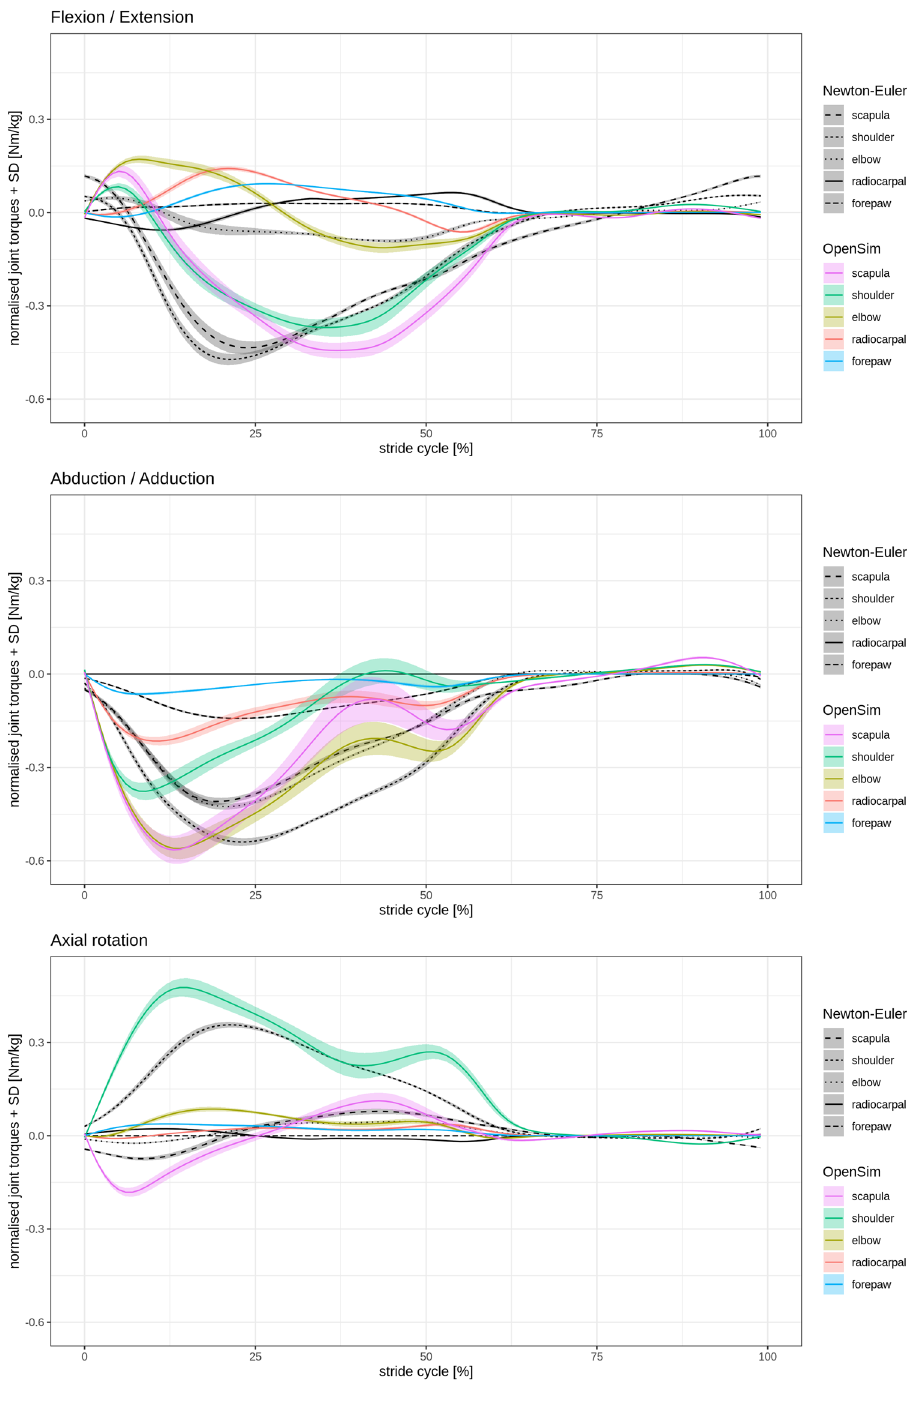
Figure 2. Forelimb calculated torques for the flexion/extension, abduction/adduction, and axial rotation in a walking Beagle based on consecutive strides of the same trial. Comparison between results obtained from OpenSim versus Newton–Euler method. The standard deviation (SD) is shown as shaded bands. Flexion/ extension torques: positive values indicate net retractor torques and negative values indicate net protractor torques. A retractor torque flexes the shoulder joint, extends the elbow joint, and flexes the carpal joint. Abduction/adduction torques: negative values indicate abductor torque and positive values indicate adductor torque. Axial rotation torques: negative values indicate external rotation torques and positive values indicate internal rotation torques. The figures were created with the software package R 70